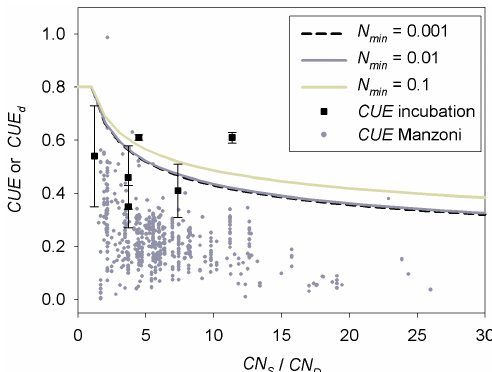
Figure 6. Comparison of CUE d (lines) predicted by Eq. (2) with parameter values ( m 2 = 0 . 54, n 1 = 0 . 50) calibrated based on the incubation experiments (Table A2) of Recous et al. (1995) and Guenet et al. (2010) to observed CUE of terrestrial microorgan- isms along a gradient of CN S / CN D . For observed CUE (dots), CN D and CN S are the C:N ratio of decomposers and their sub- strates, respectively. For simulated CUE (lines), CN S and CN D cor- respond to the C:N ratio of donor (litter pool) and acceptor (the active SOM pool of the CENTURY), respectively. Gray dots are the estimated microbial CUE of litter decomposition in natural ter- restrial ecosystems from Manzoni et al. (2017). Black squares are the microbial CUE measured via laboratory incubation experiments of Gilmour and Gilmour (1985), Devêvre and Horwáth (2000) and Thiet et al. (2006). Error bars represent the standard deviations. N min (gNkg − 1 soil) is the concentration of soil mineral